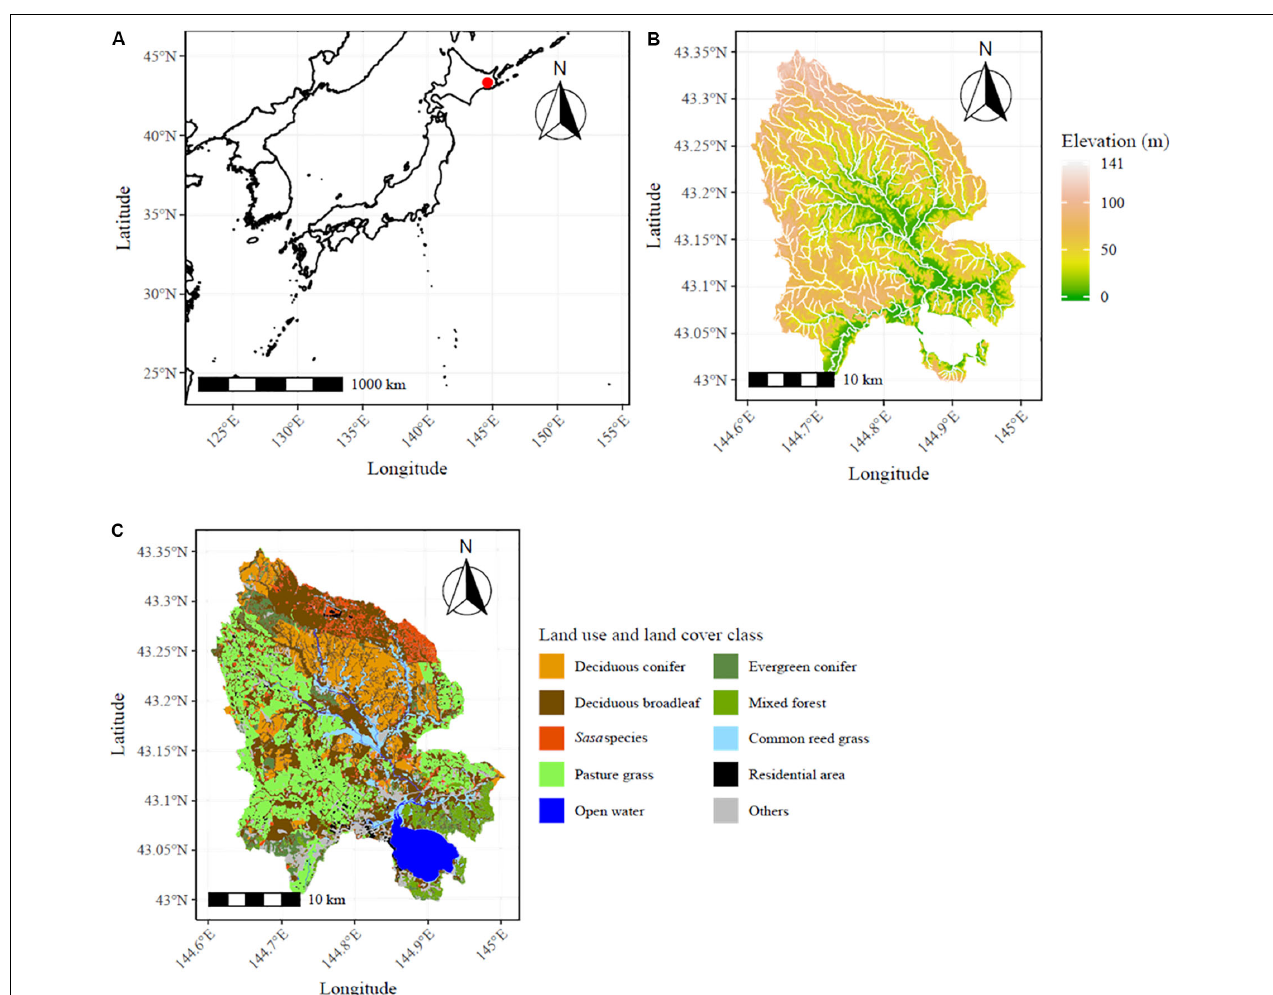
FIGURE 1 | Description of the study area. (A) The location of the Bekambeushi River watershed (red dot), (B) the digital elevation model and distribution of rivers (white lines), and (C) the vegetation distribution.